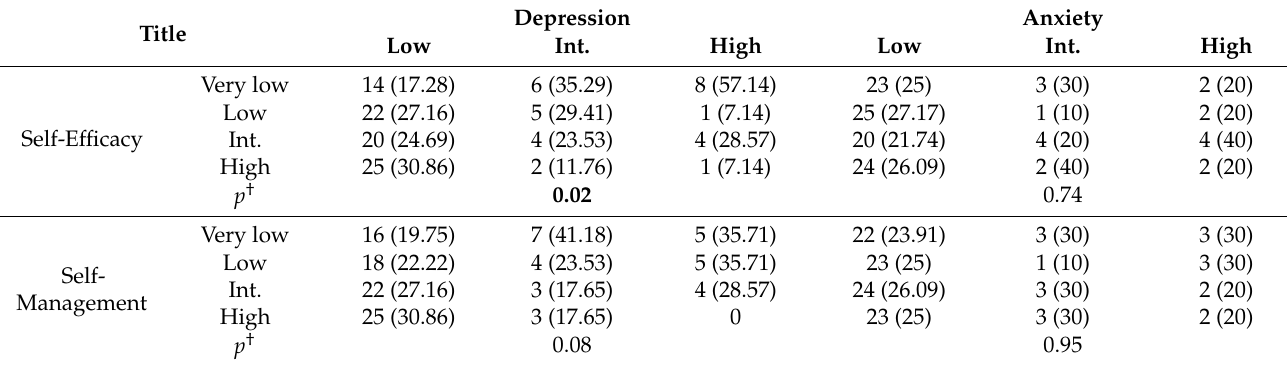
Table 6. Frequency analysis between three levels of anxiety and depression and four levels of self-management and self-efficacy.